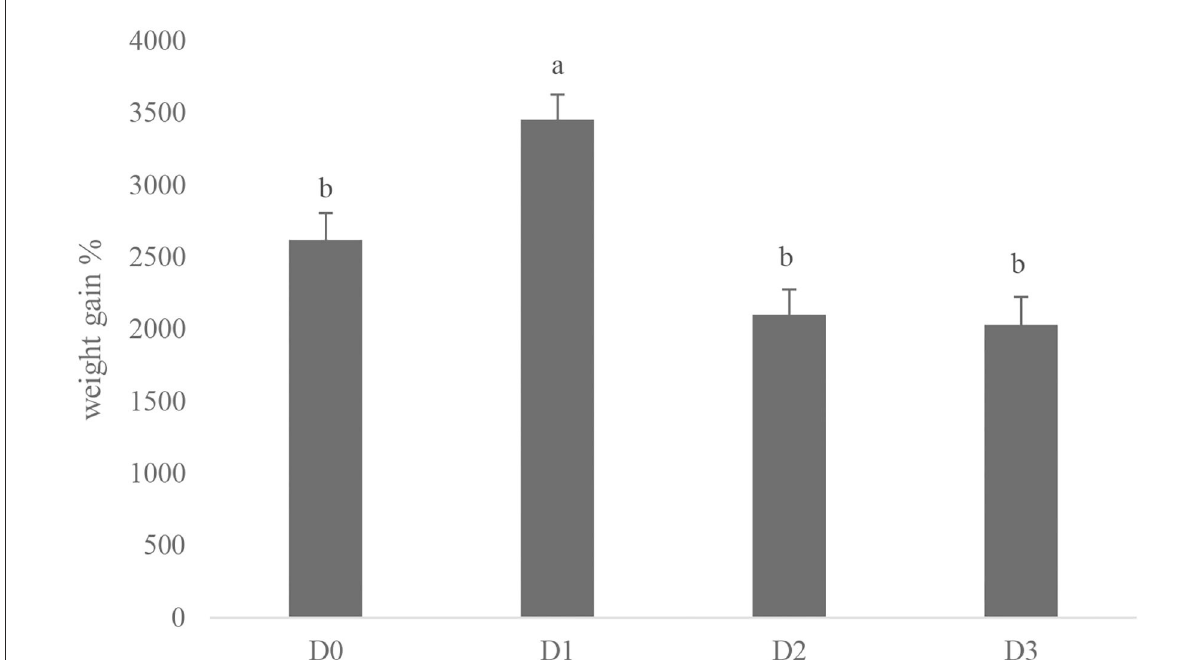
FIGURE1 Percent weight gain of seawater-tolerant tilapia fed with diets supplemented with T. weissflogii paste. Bars with different superscripts indicate significant differences between treatments ( P <